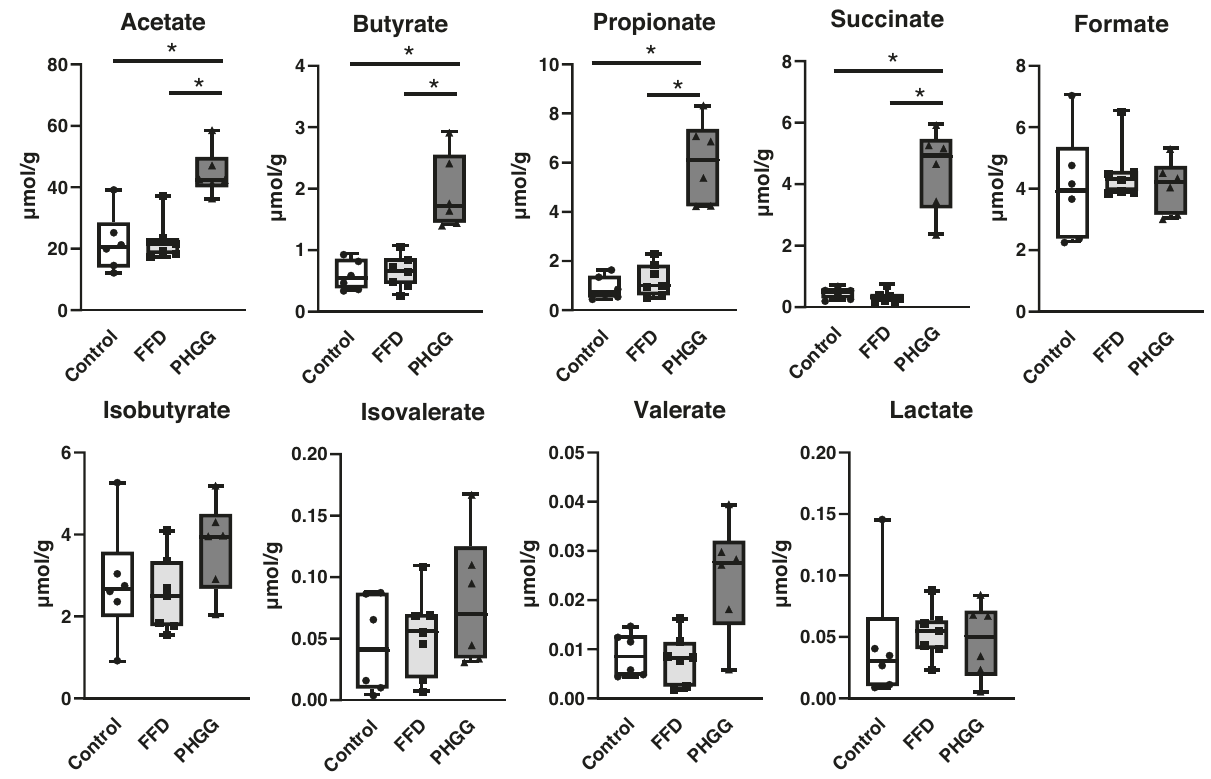
Fig. 2 Concentration of short-chain fatty acids in fresh stool. * p <